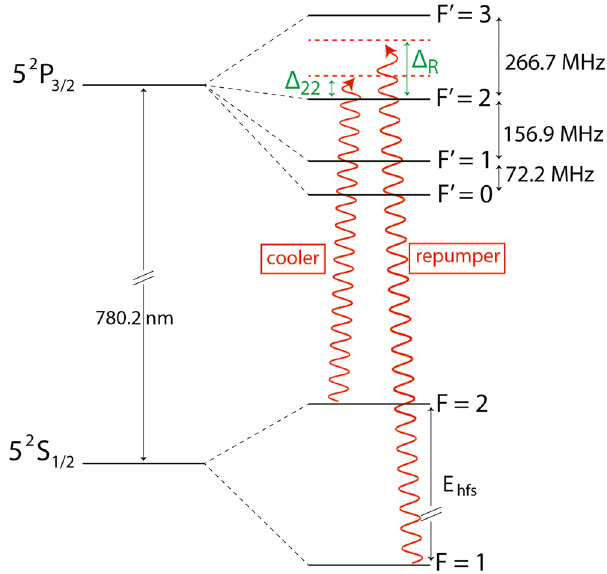
Figure 1. Scheme of the energy levels of the D 2 transition in 87 Rb. Red arrows represent the two frequencies employed for the grey molasses; cooler(repumper) is blue-detuned with respect to the F = 2(1) → F ′ = 2 transition, with detuning Δ 22 ( Δ R ). E hfs denotes the ground-state hyperfine splitting, equal to h × 6834.683 MHz. All other hyperfine splittings are indicated with the corresponding